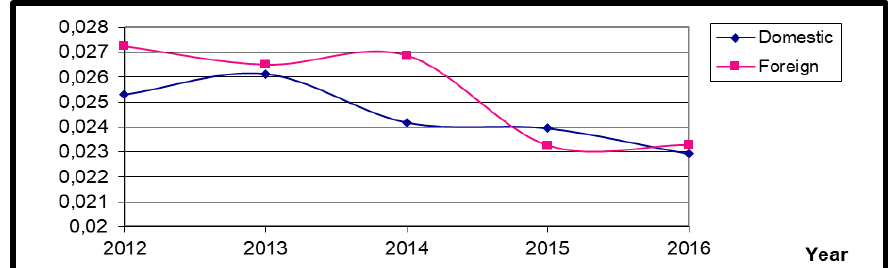
Table 6: The Pearson’s Correlation Coefficients of the study variables